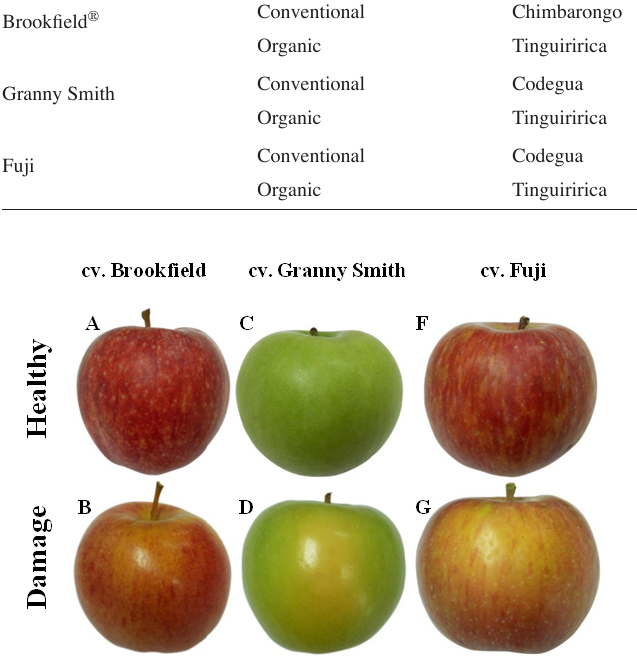
Fig. 1: Apples used in the test. Above healthy fruits. (A and B cv. Brook- field ® ; C and D cv. Granny Smith; F and G cv. Fuji).